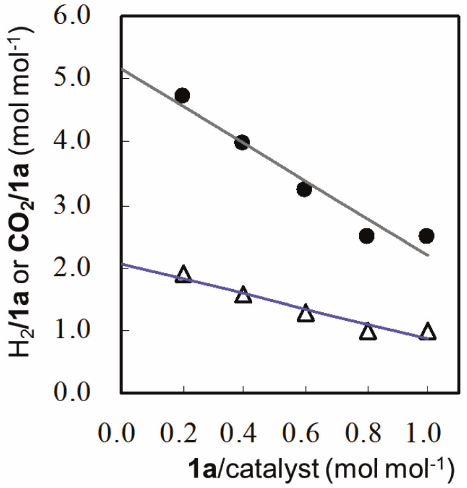
Figure 1. Plots of H reaction of 1,2-aminoethane ( 1a ).